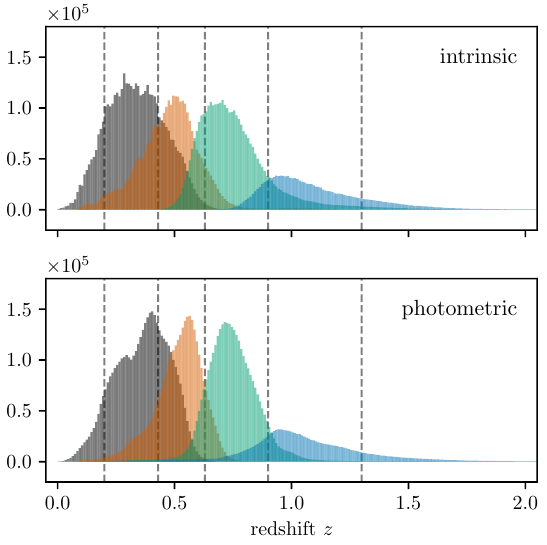
Figure 4. Top: Tomographic lensing efficiency q ( x ) from photo- metric redshifts ( solid ) and intrinsic redshifts ( dotted ). Bottom: Absolute difference ∆ q ( x ) between photometric and intrinsic lens- ing efficiencies.